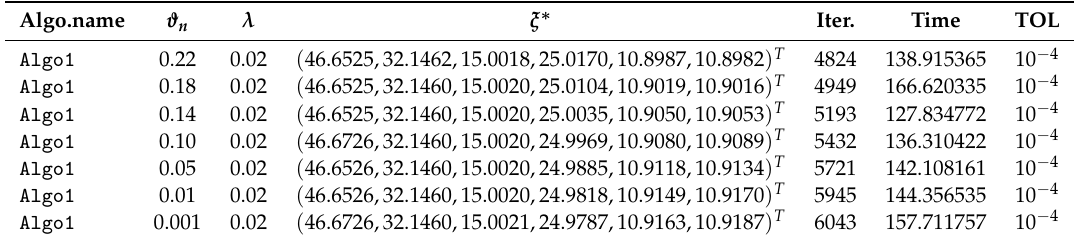
Figure 1. Experiment in Section 6.1.1: Algorithm 1 behaviour for different values of ϑ n . Table 3. Experiment in Section 6.1.1: Algorithm 1 performance for varying parameters extrapolation factor ϑ n